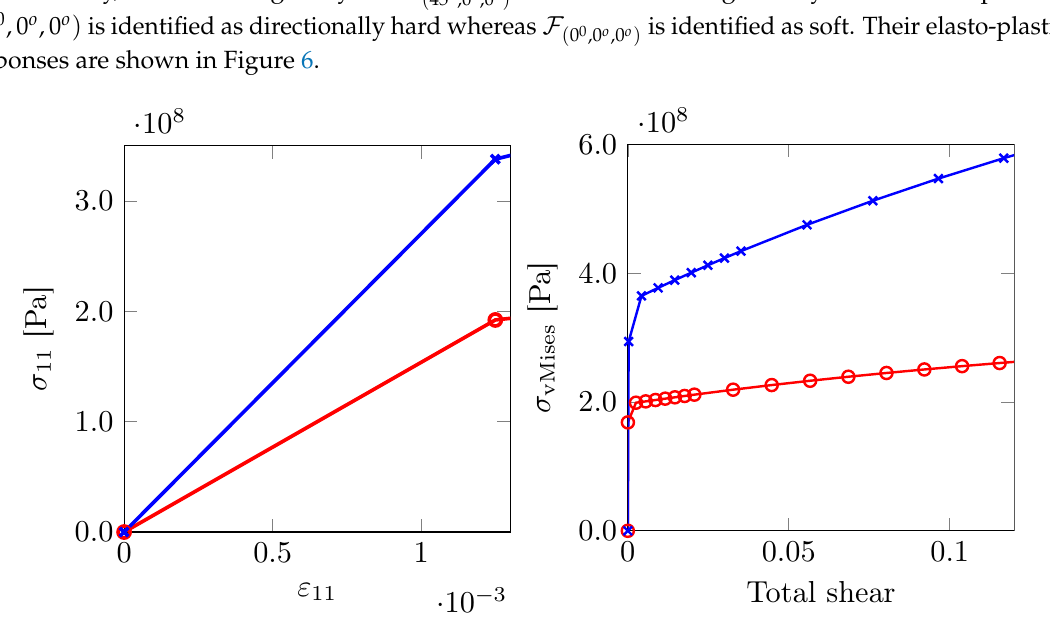
Figure 6. Overall stress–strain response of a single crystal of ferrite. Directionally hard (blue, ) oriented and a soft (red, F ( 0 0 ,0 o ,0 o )